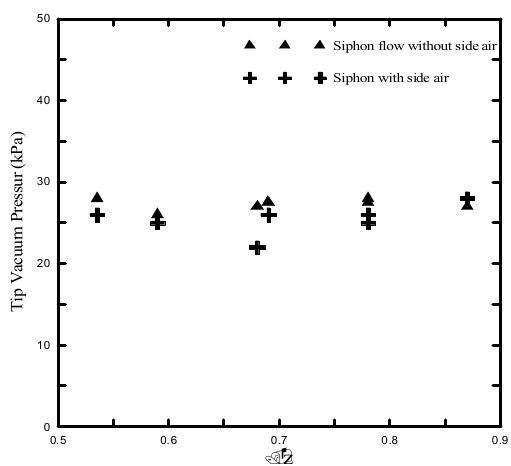
Figure 5. Effect of side air on the water siphon flow.